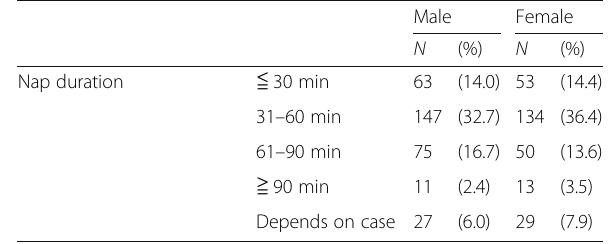
Table 1 The characteristics of daily schedules in elite Japanese